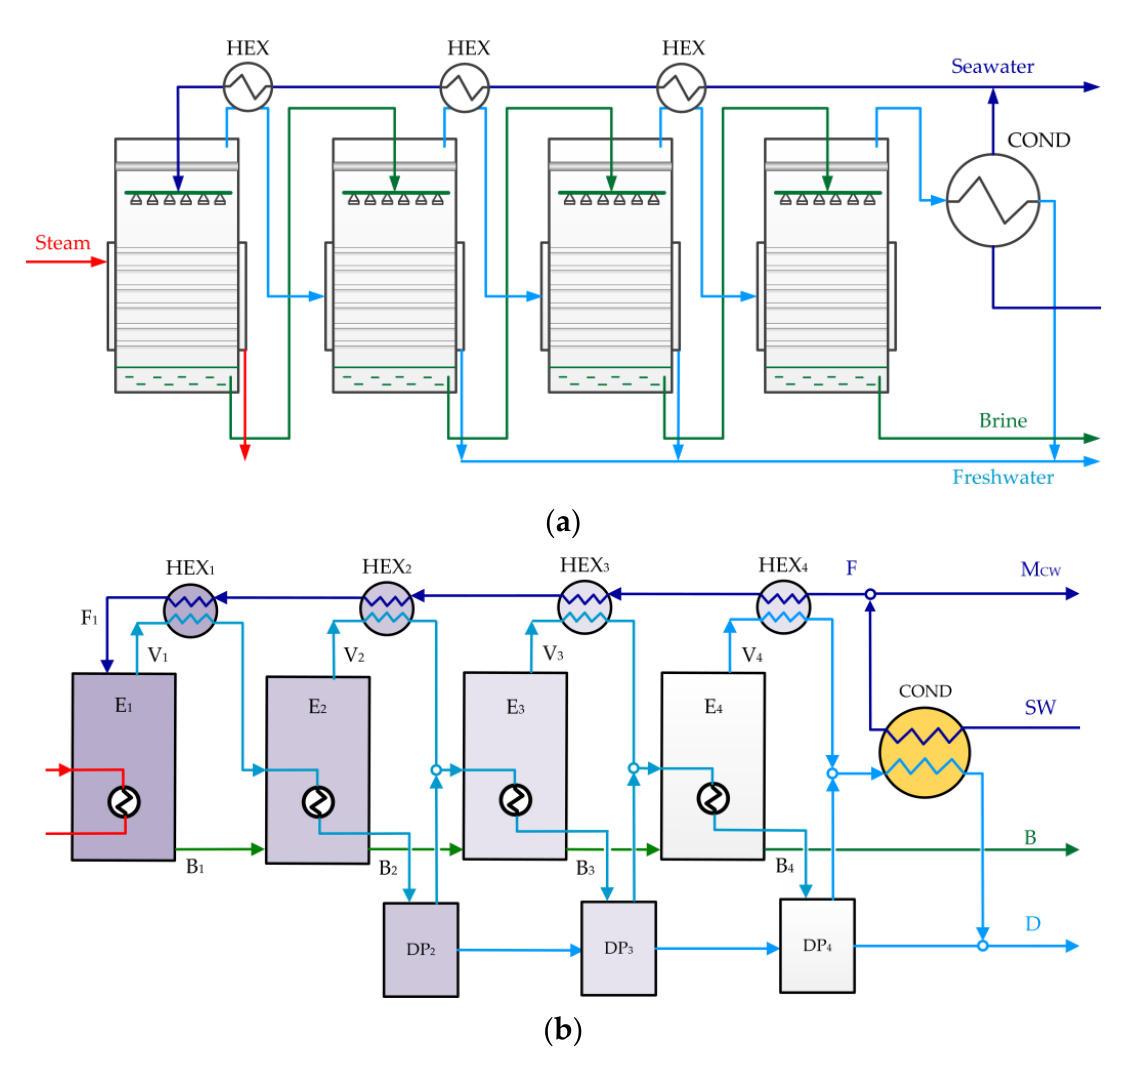
Figure 3. MED desalination system: ( a ) schematic; ( b ) representation for mathematical modeling.